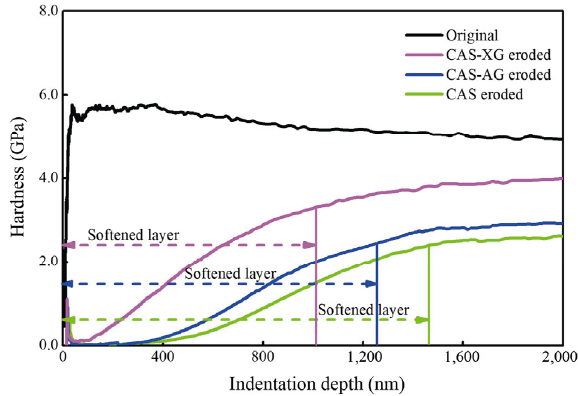
Variations of nanoindentation hardness of enamel surfaces versus indentation